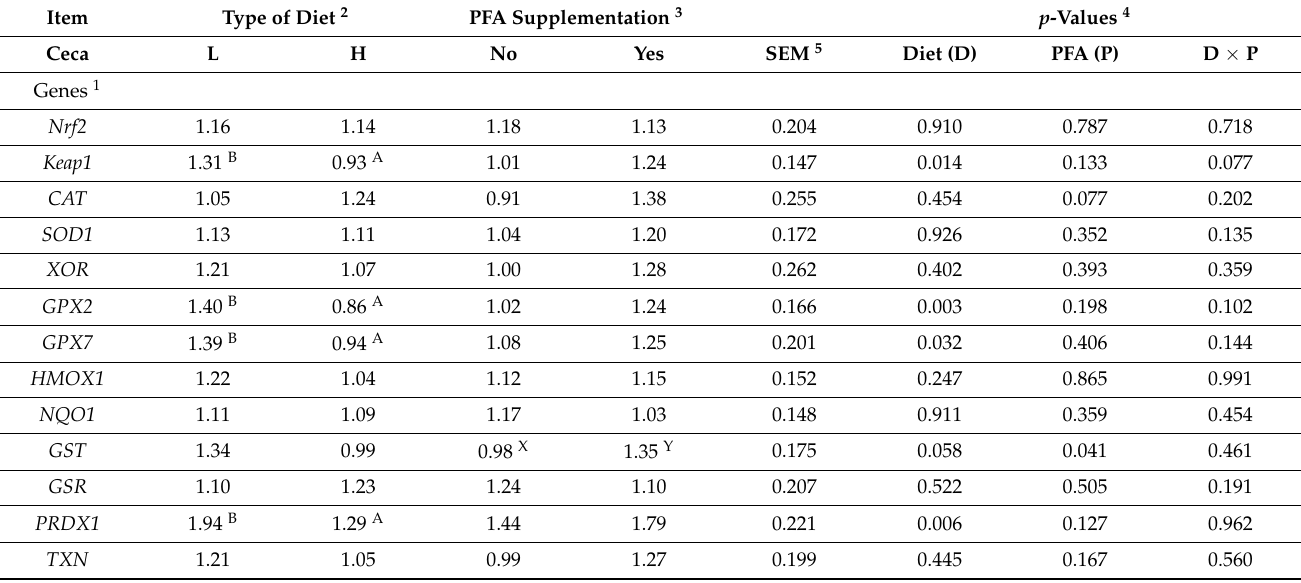
Table 6. Relative expression of the Nrf2 /ARE pathway genes in cecal mucosa of 42-day-old